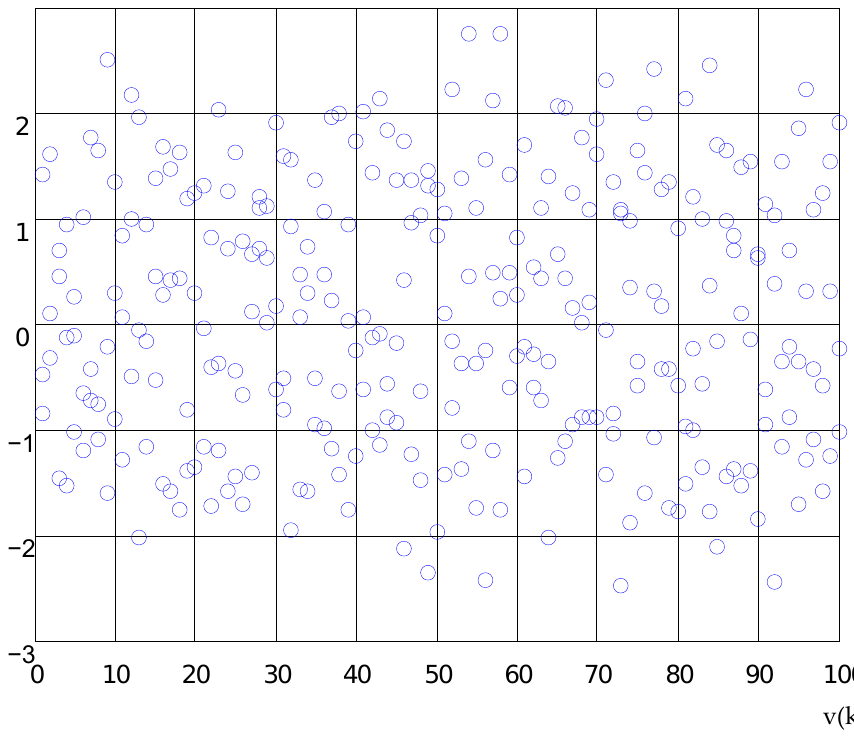
Figure 4. The original data of vehicle speed.